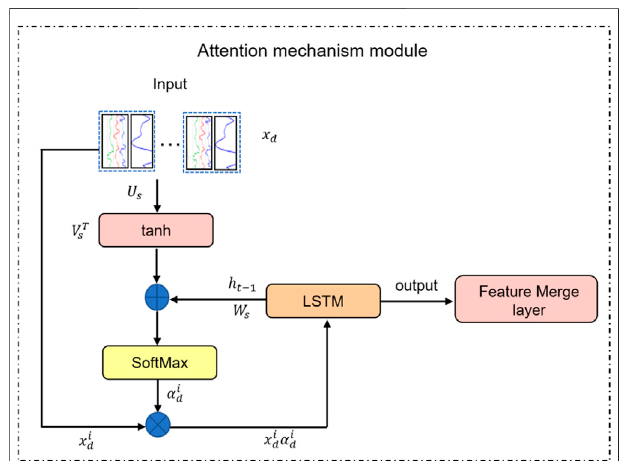
α i d is attention weight